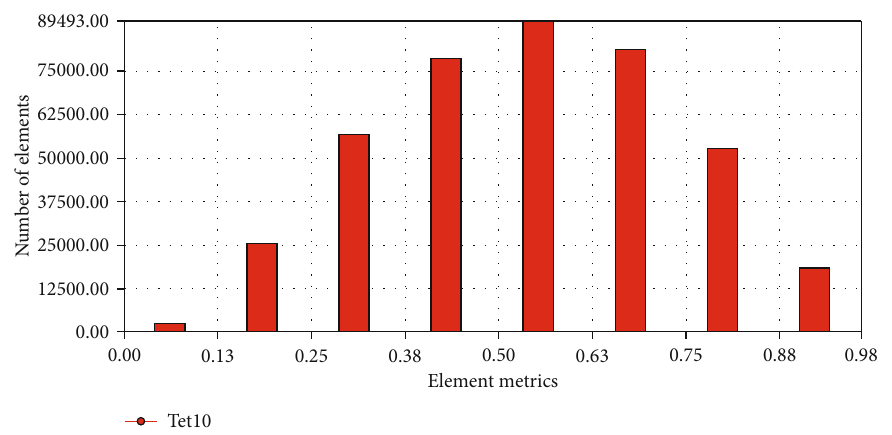
Figure 15: Element quality.